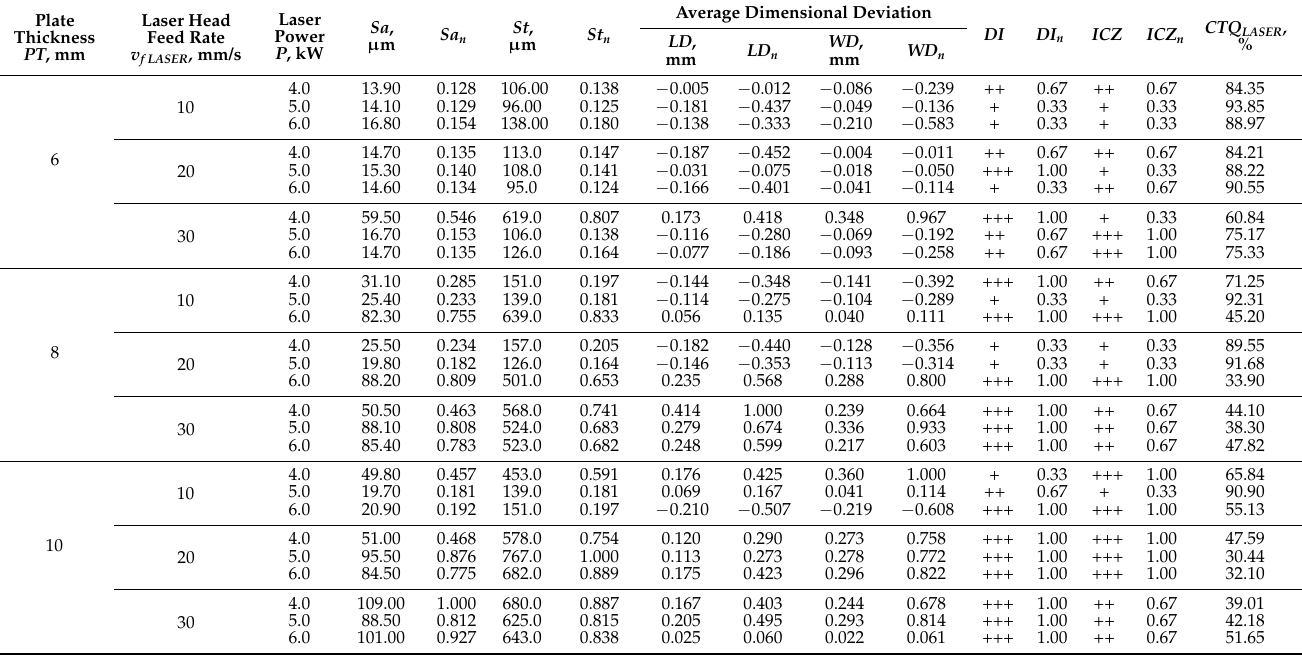
Table 4. List of the values of factors (before and after normalization) enabling the determination of cutting technological quality index after laser cutting CTQ LASER (subscripts n denote values after normalization).